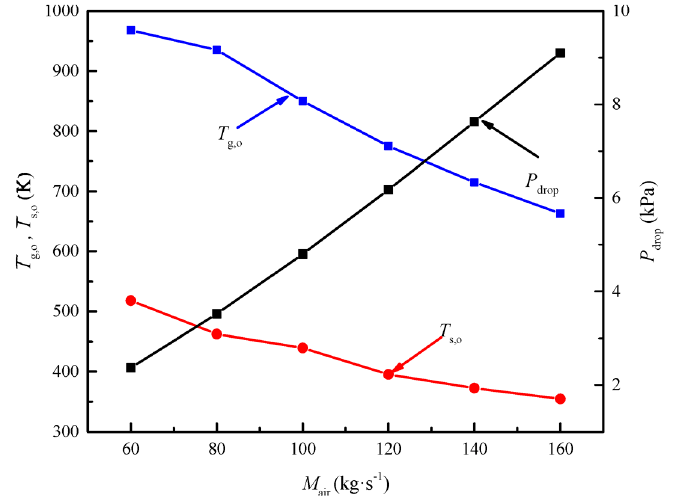
Figure 5. E ff ect of the air mass flow rate on the air and sinter outlet temperatures and the pressure drop of cooling